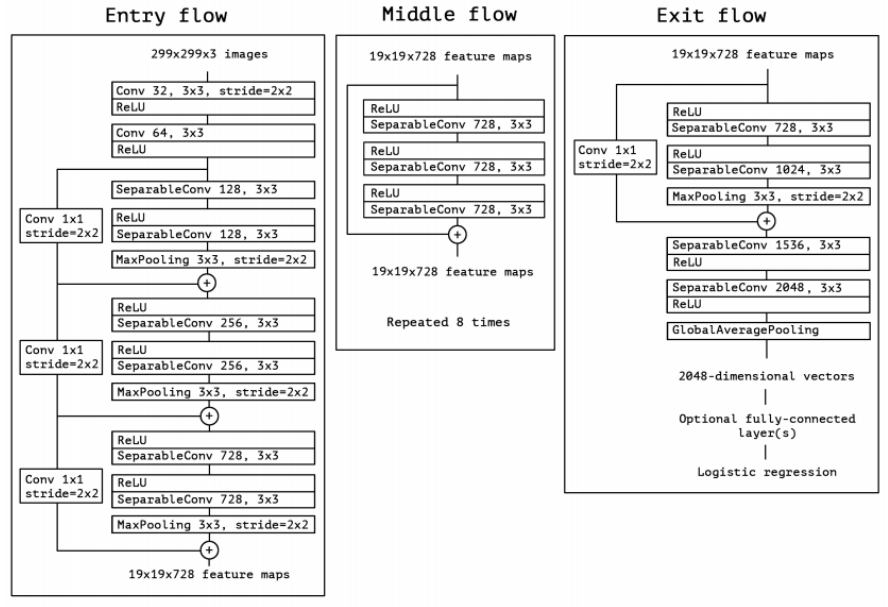
Figure 2. Detailed structure of the Xception model [39]. Reprinted with permission from [39]. Coypright 2017